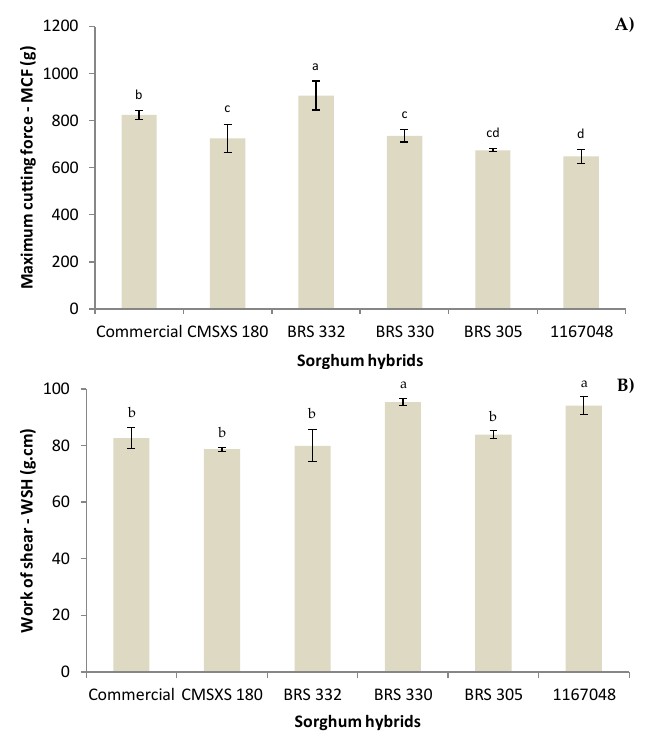
Figure 2. Texture analysis of GFPa produced with sorghum flour as 50% of the starch source: ( A ) maximum cutting force (MCF); ( B ) work of shear (WSH). Bars with the same letters do not differ significantly ( p > 0.05) .